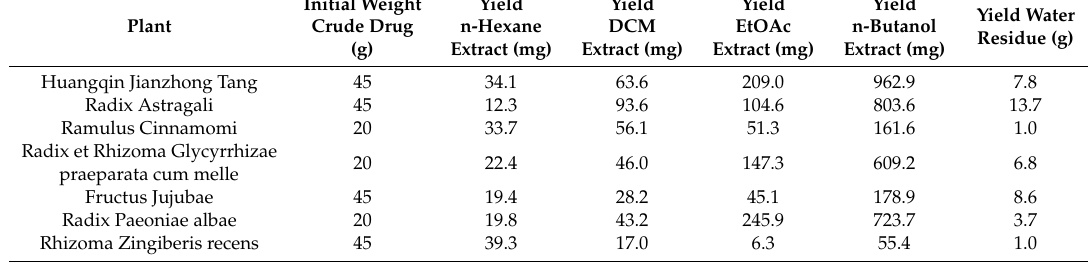
Table A1. Extract Yields obtained by liquid-liquid extraction of HQJZT and its single herbal components.